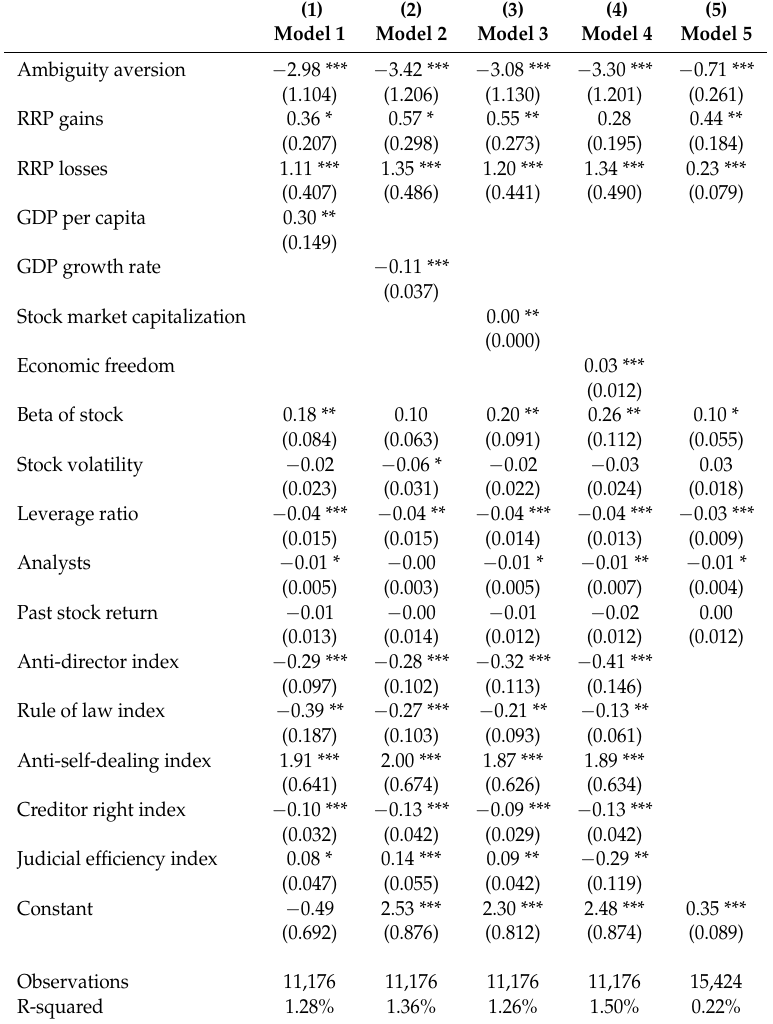
Table 5. Regression results for the equity premium, ambiguity aversion and risk preferences. RRP, relative risk premium.